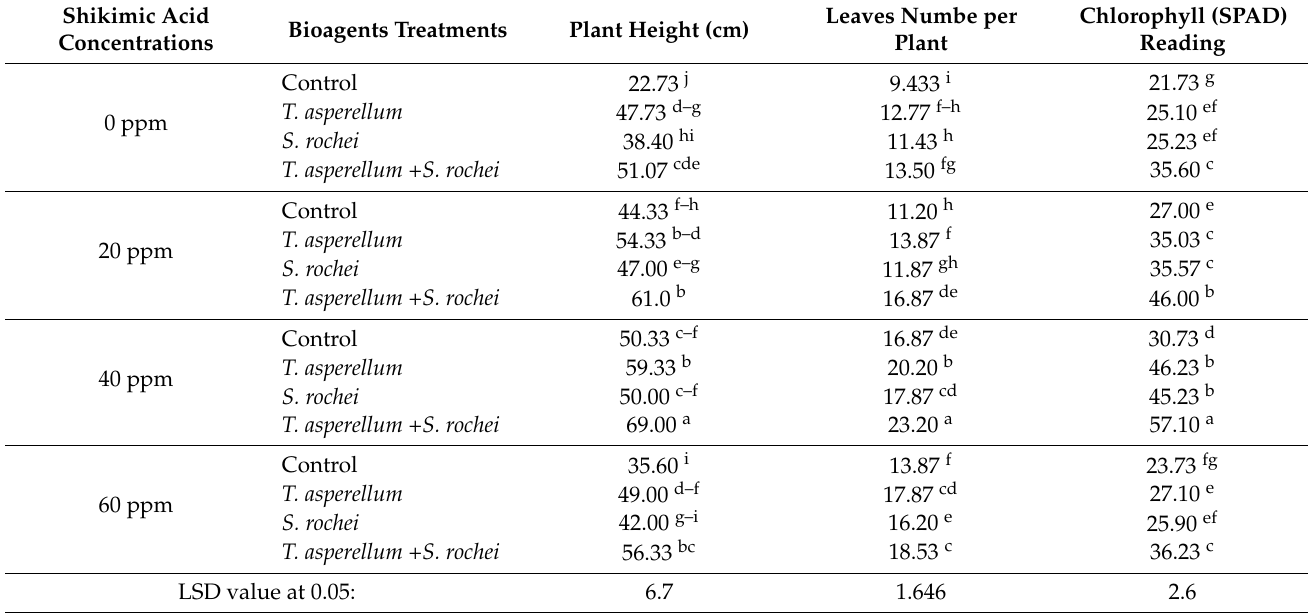
Table 2. Effect of the interaction between seed priming of shikimic acid (0, 20, 40, 60 ppm) and foliar applications with S. rochei (SR), T. asperellum (TS), S. rochei + T. asperellum (SR + TS), and water (control) on the vegetative growth characteristics of squash plants during the first experiment.